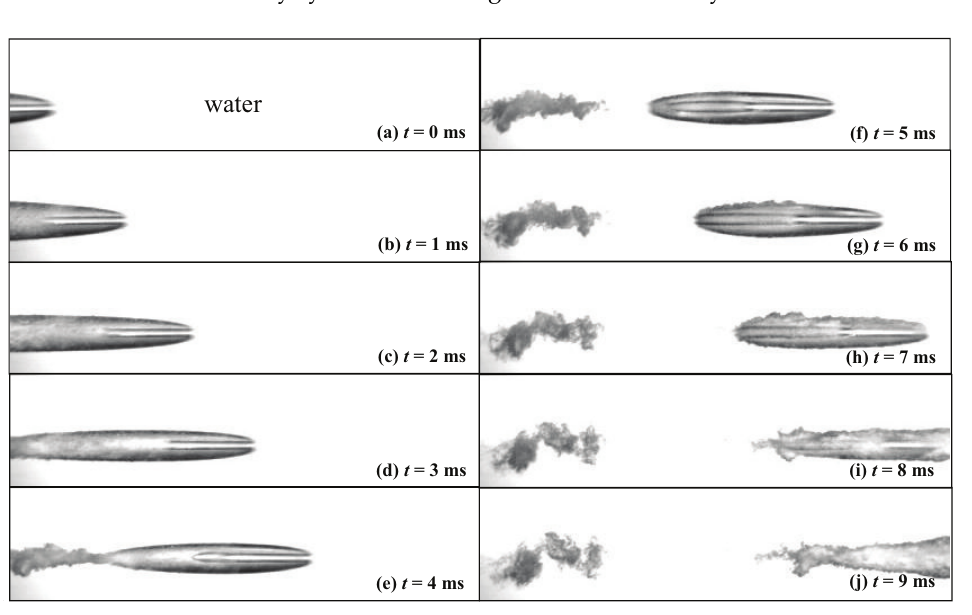
Figure 6. Supercavitation evolution of the projectile with hydrophobic coating under the water depth of 16.7D ( ∆ t = 1 ms, V 0 = 38.3